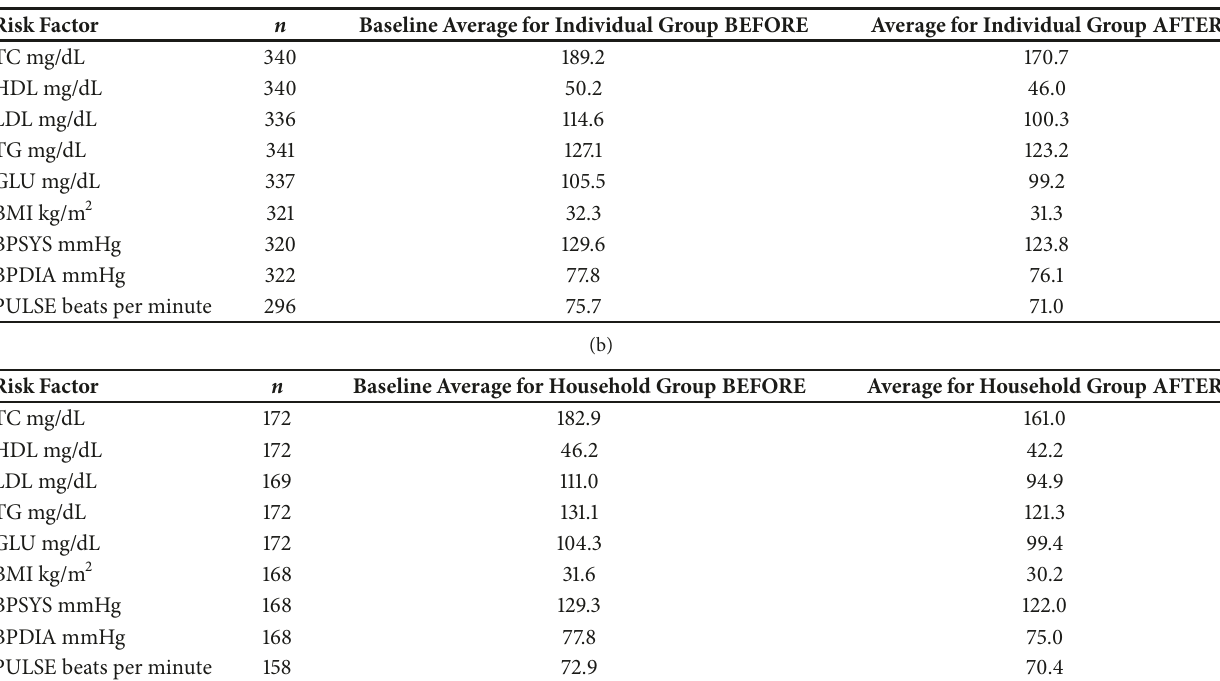
Table 2: Baseline averages were calculated before CHIP intervention and after for both those who participated alone (Individual) and those who participated with household members (Household). Abbreviations. Total cholesterol (TC), high-density lipoprotein cholesterol (HDL), low-density lipoprotein cholesterol (LDL), triglyceride (TG), fasting blood glucose (GLU), body mass index (BMI), systolic blood pressure (BPSYS), and diastolic blood pressure (BPDIA).